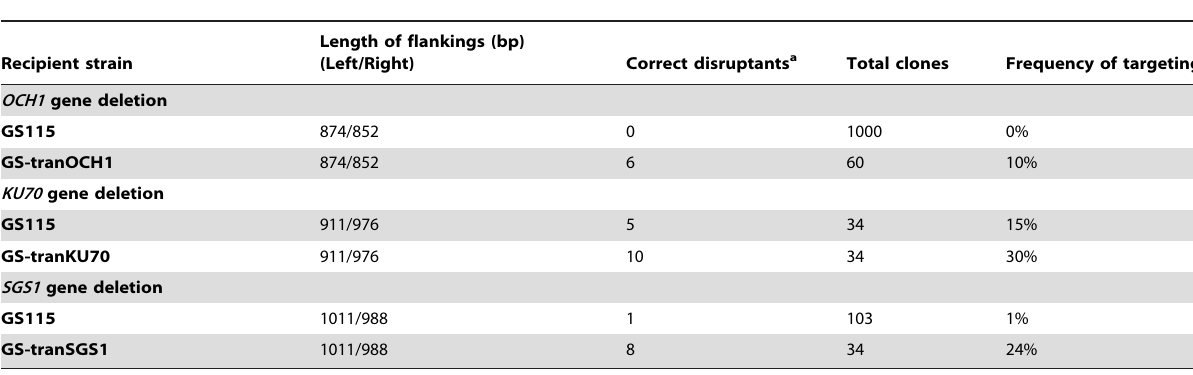
Table 2. Comparison of gene targeting efficiencies between conventional and new strategies.